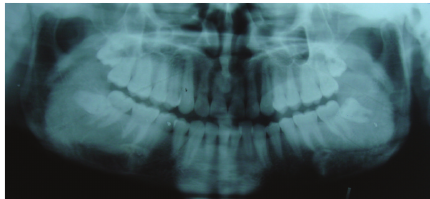
Figure 13: Panoramic radiograph of the patient’s